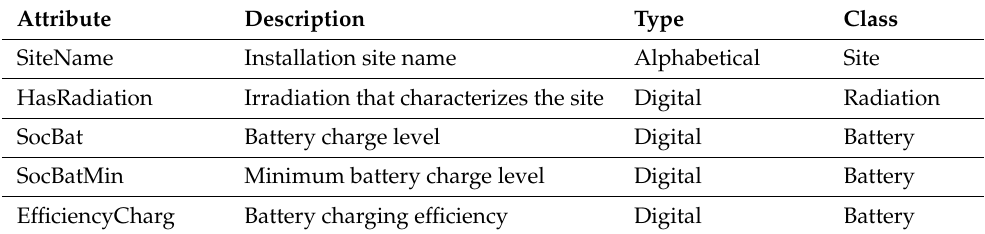
Table 2. An extract of the